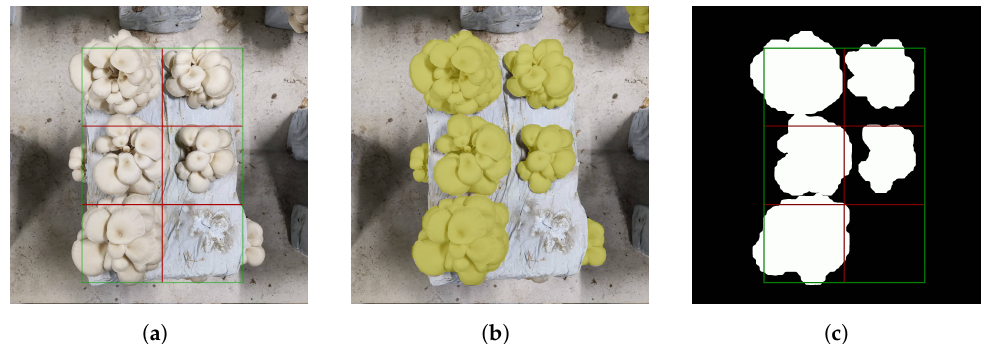
Figure 6. Example photos of mushroom growth monitoring. ( a ) Bounding box divided into six equal rectangles; ( b ) Masks of the detected mushrooms; ( c ) Masks in the six rectangles of the bounding box.